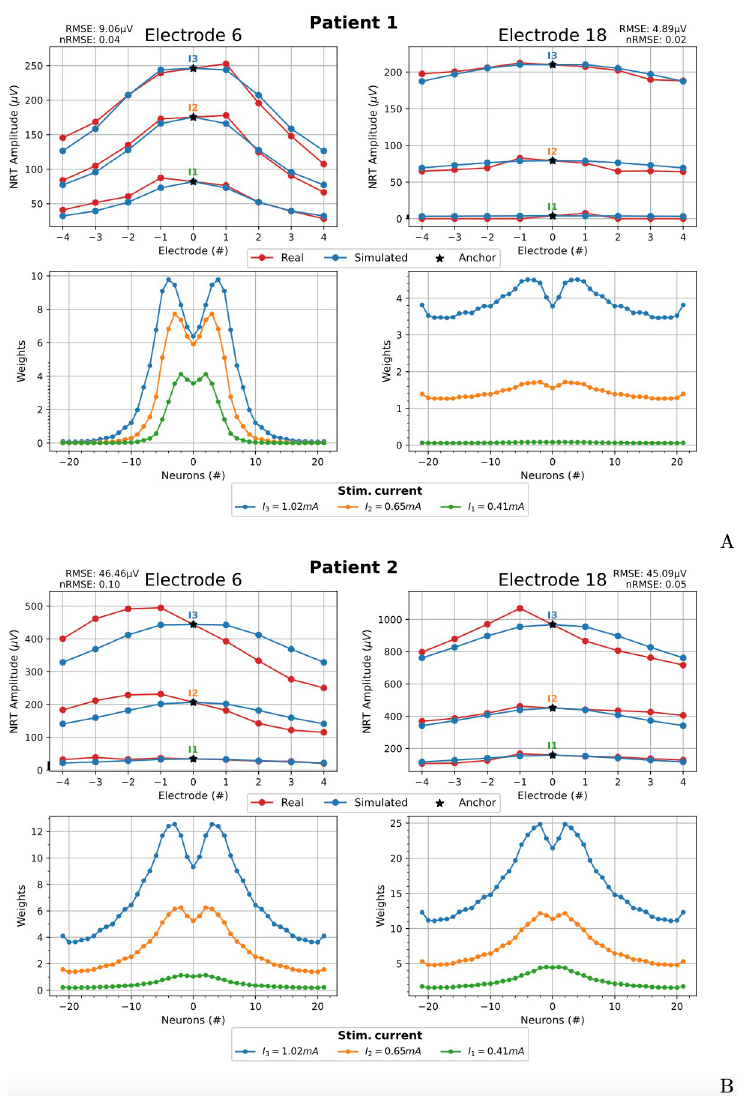
Fig 10. Symmetric fitting. Comparison between real and simulated NRT amplitudes for the two patients at the electrodes 6 (basal) and 18 (apical) (upper row A and B). Corresponding weights � w 0 anchor electrode is 0 in both cases. RMSE and normalized RMSE (nRMSE) values are